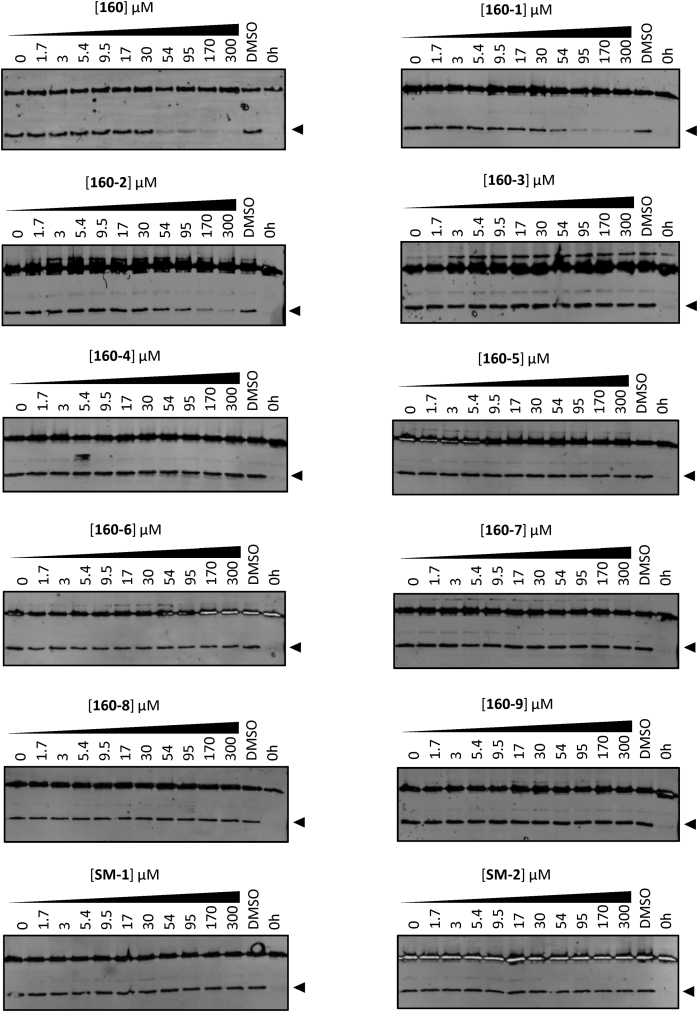
Structure activity relationship analysis of 160 analogues in vitro. JFH1 NS2-3 autoproteolysis reactions were treated with indicated concentrations of each analogue for 16 h before SDS-PAGE/ Western blot analysis. NS3-FLAG proteolysis product (arrowhead) was quantified to determine EC50 (reported in Table 1).